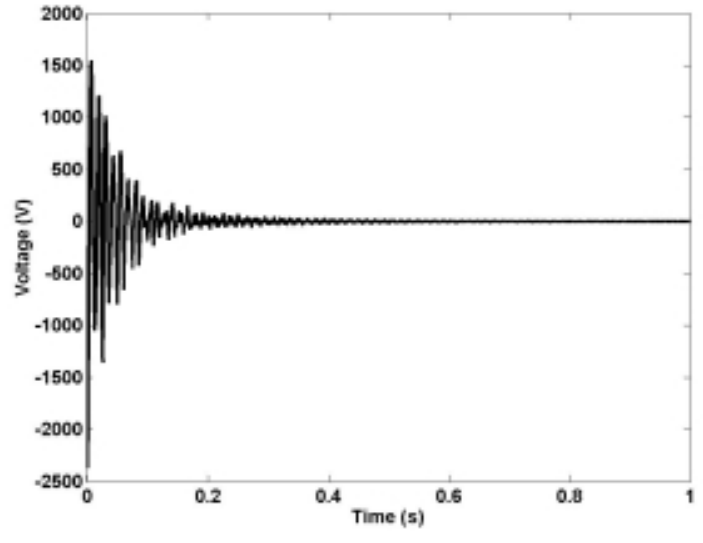
Fig. 7. Feedback control voltage applied by the piezoelectric actuator when the IMSC strategy is